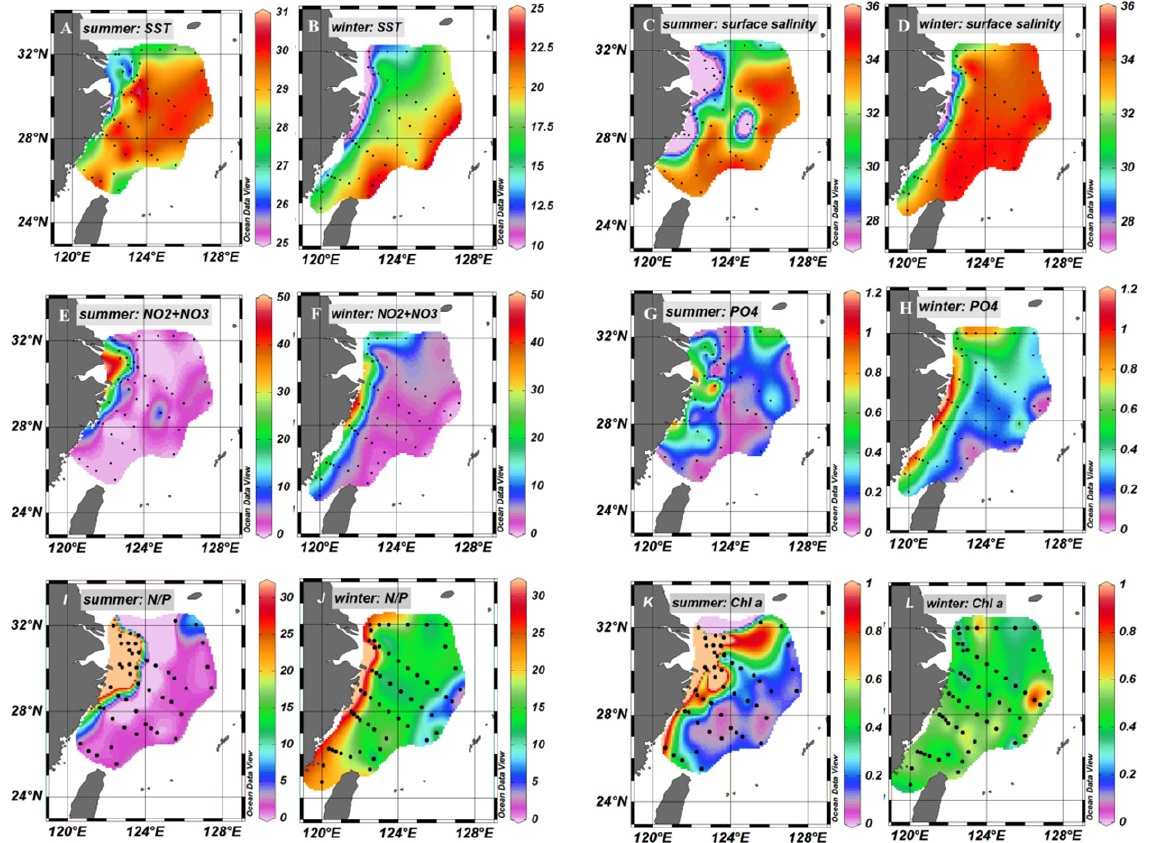
Fig. 2. Spatial distributions of sea surface (A, B) temperature, (C, D) salinity (psu), (E, F) NO − PO 3 − concentration (µgL − 1 ), (I, J) N/P molar ratio, and (K, L) Chl a concentration (µgL − 1 ) in summer (18–27 August 2009) and 4